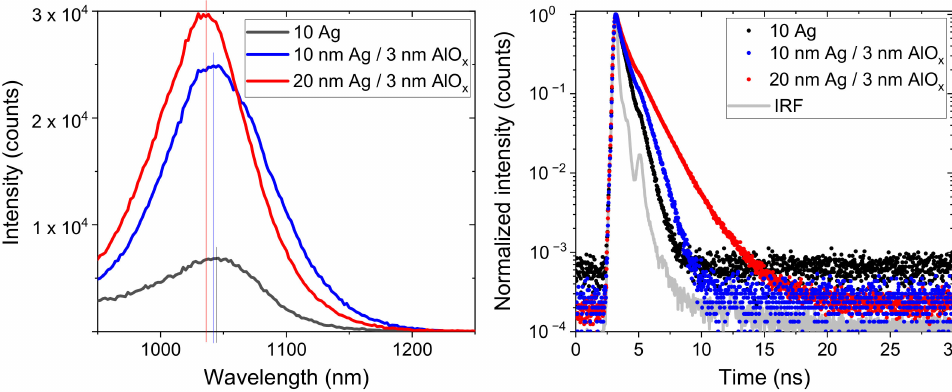
Figure 4. PL ( left ) and TRPL ( right ) data of Ag containing solar cells. IRF is the instru- mental response